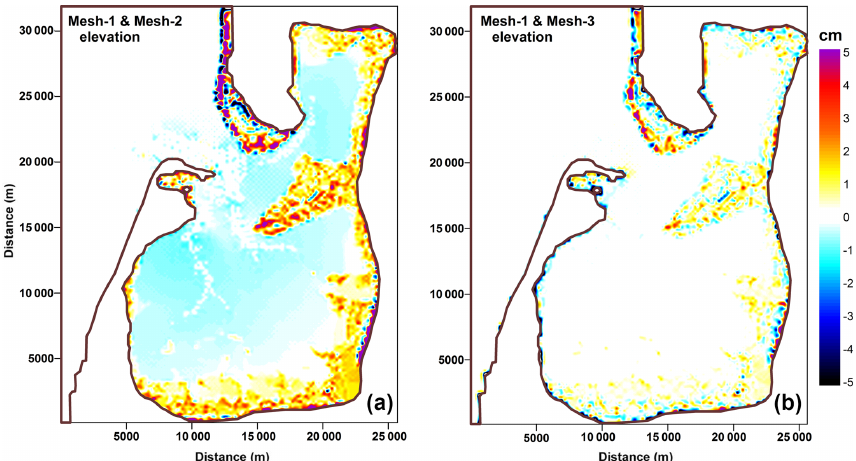
Figure 8. Spatial distribution of the elevation differences for a full tidal period for MESH-1 and MESH-2 (a) and for MESH-1 and MESH- 3 (b) .